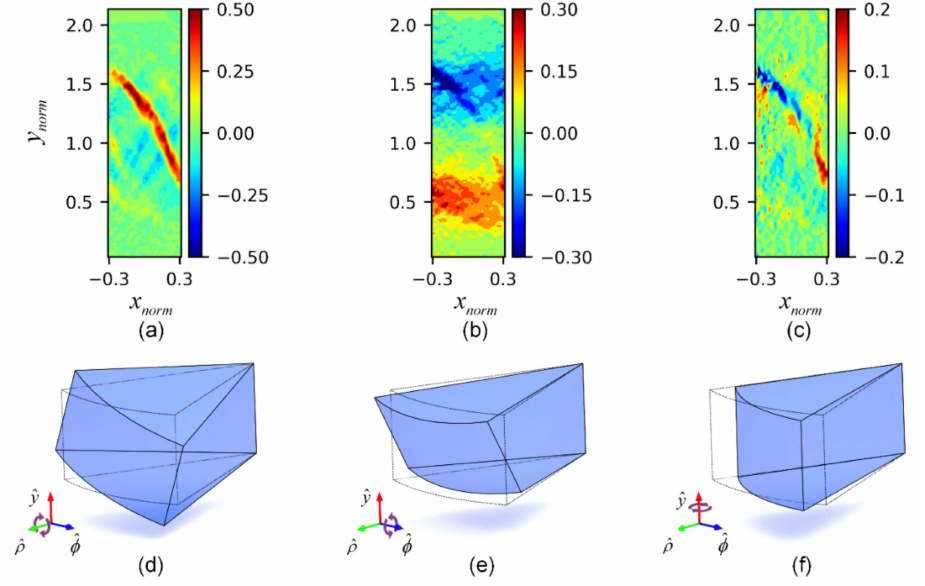
Figure 6. Curl components calculated based on test 092903b at loading level of ε a = 9.6%: ( a ) curl field with respect to ˆ ρ axis; ( b ) curl field with respect to ˆ φ axis; ( c ) curl field with respect to ˆ y axis; ( d ) illustration of positive rotation for curl along ˆ ρ axis; ( e ) illustration of positive rotation for curl along ˆ φ axis; ( f ) illustration of positive rotation for curl along ˆ y